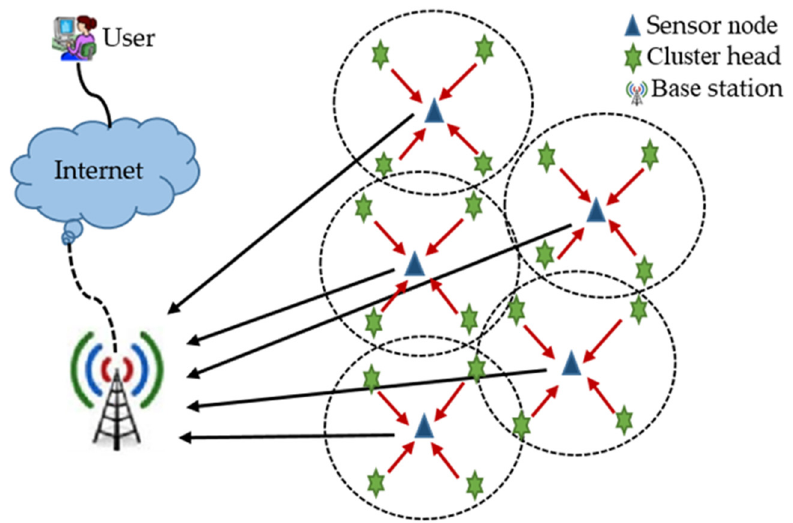
Figure 2. Clustering in WSNs.